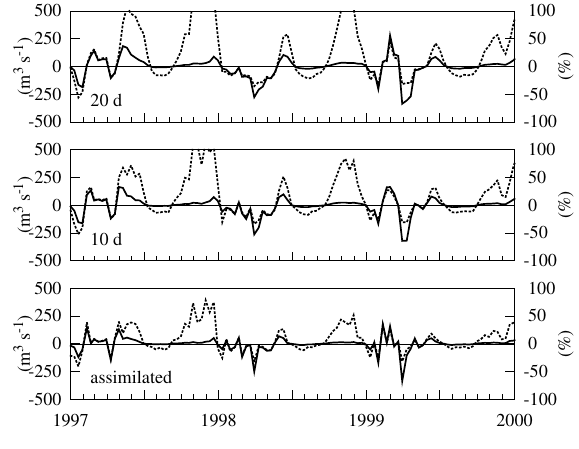
Fig. 6b. Absolute (solid line) and relative (dashed line) forecast error for the Kafue watershed for the different forecast periods and the assimilation